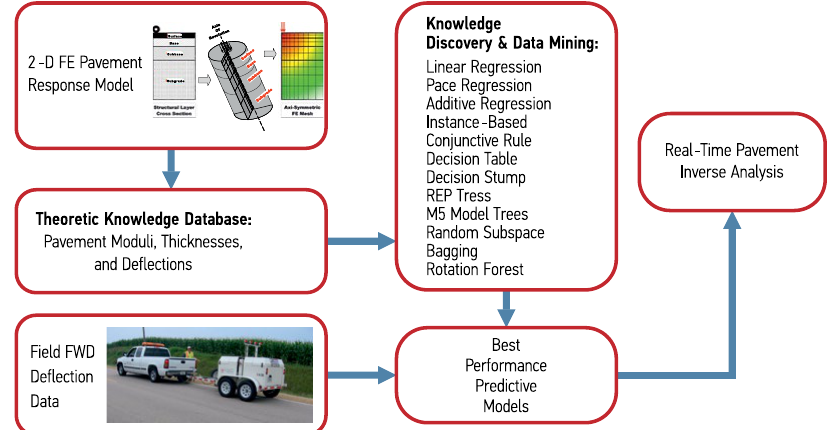
Fig. 2. Schematic of overall proposed approach to real-time flexible pavement inverse analysis with knowledge discovery and data